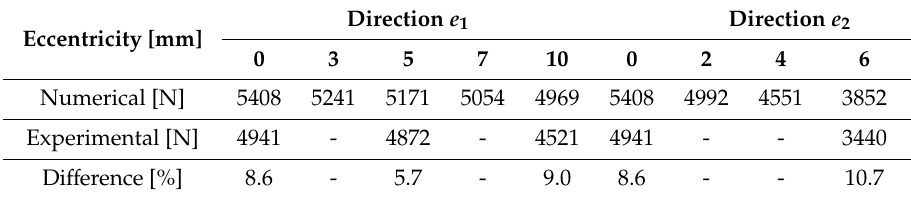
Figure 11. Failure load: ( a ) eccentricity e 1 ; ( b ) eccentricity e 2 . Table 3 lists the obtained failure loads depending on the direction of the eccentricity. Table 3. Composite material damage initiation load P d versus eccentricity.